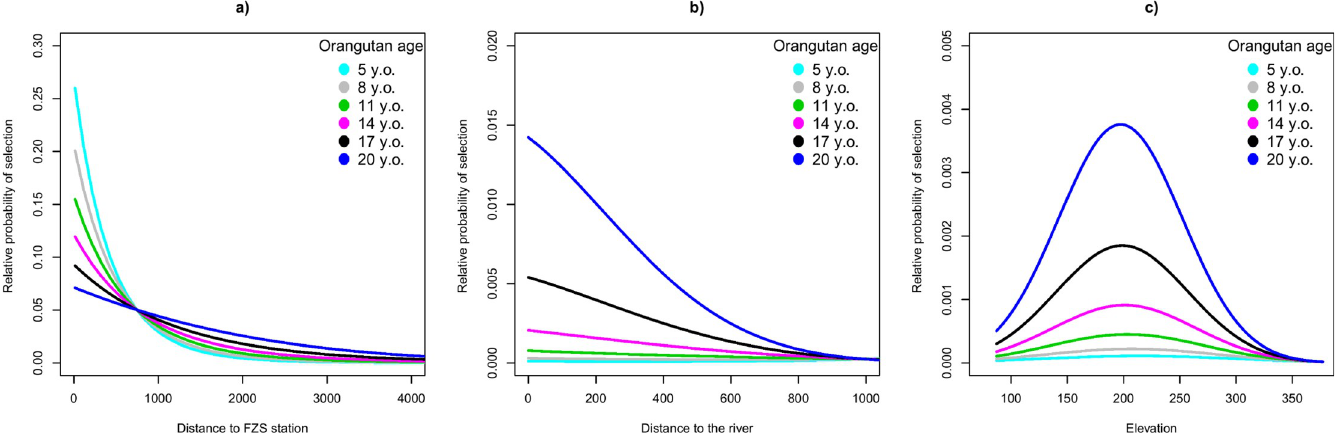
Fig 2. Habitat selection patterns become more pronounced in older orangutans. Relative probability of selection in 32 orangutans (n = 13 females, n = 19 males) as a function of orangutan age (six different scenarios for age, in y.o.) interacted with the distance to the FZS station (a, in meters), the distance to the nearest river (b, in meters), and elevation (c, in meters). The lines represent the average relative probability of selection as predicted by the resource selection function.